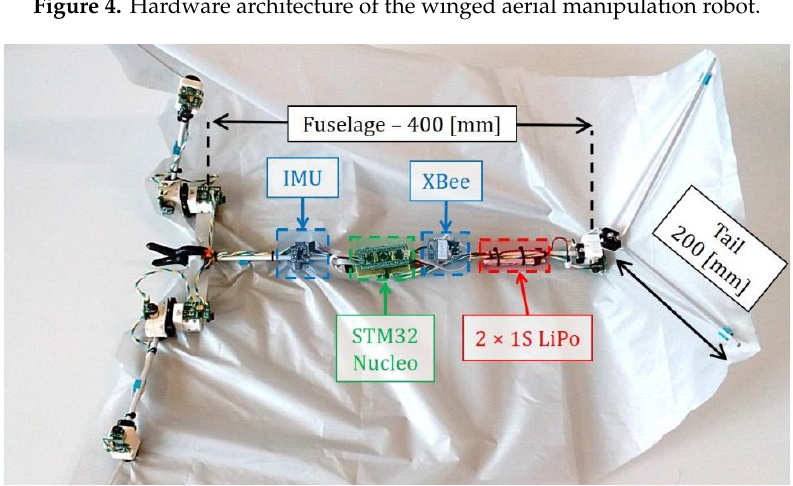
Figure 5. Components and dimensions of the winged aerial manipulator.